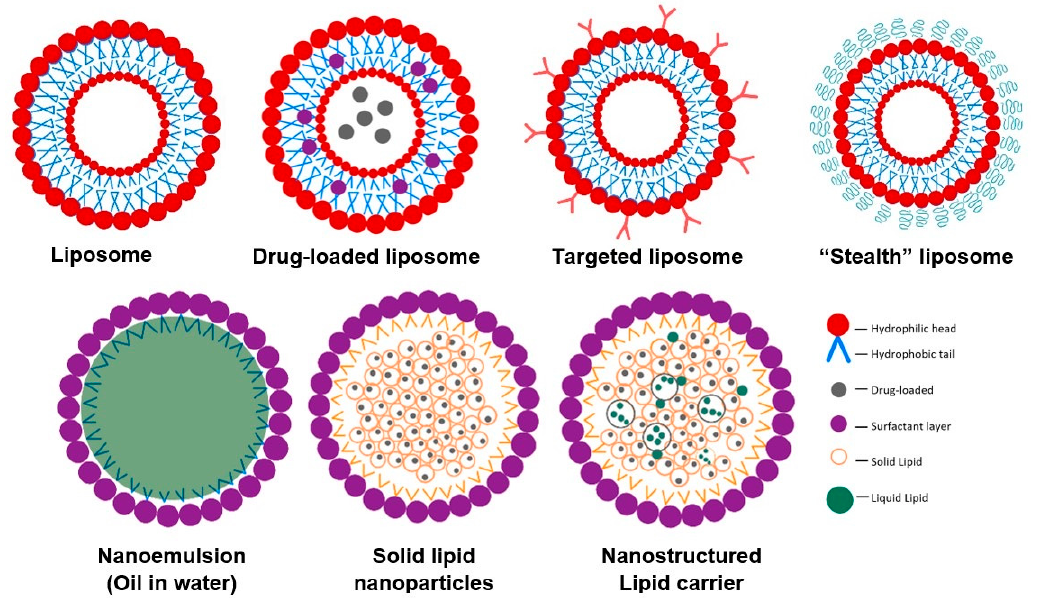
Figure 5. Schematic representation of antimicrobial agent lipid-based delivery